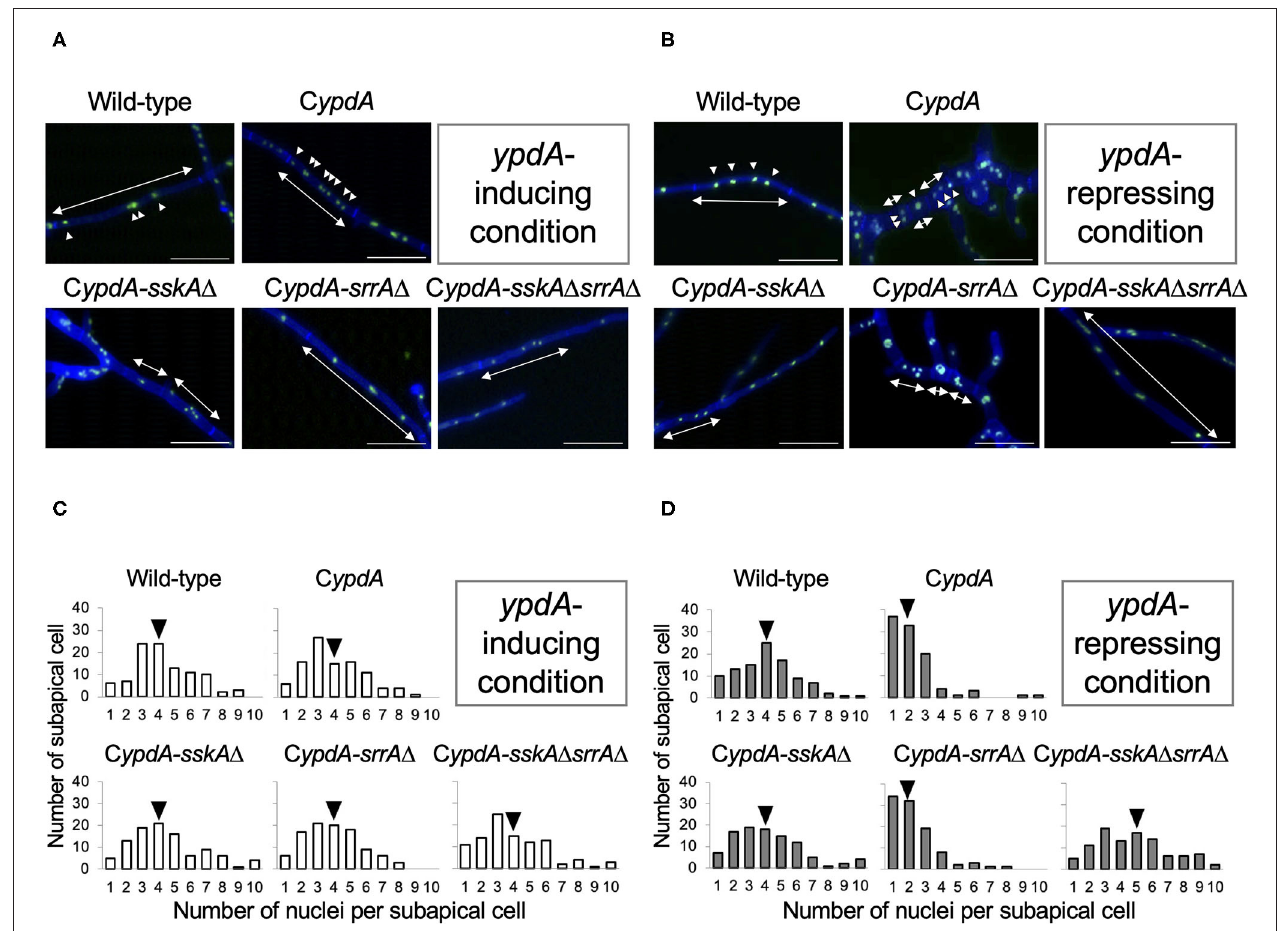
FIGURE 6 | Fluorescent observation of nuclei (A,B) and distribution of nuclei between septa (C,D) in the wild-type, C ypdA , and its derivative strains under ypdA -inducing and -repressing conditions. (A,B) Nuclei were visualized by using GFP-fused histone H2B under ypdA -inducing (A) and -repressing (B) conditions. Double-headed arrows indicate distance between septa. Arrowheads indicate nuclei. Scale bars, 35 µ m. (C,D) Nuclei between septa were counted in 100 cells in each strain under ypdA -inducing (C) and -repressing (D) conditions. Arrowheads indicate the